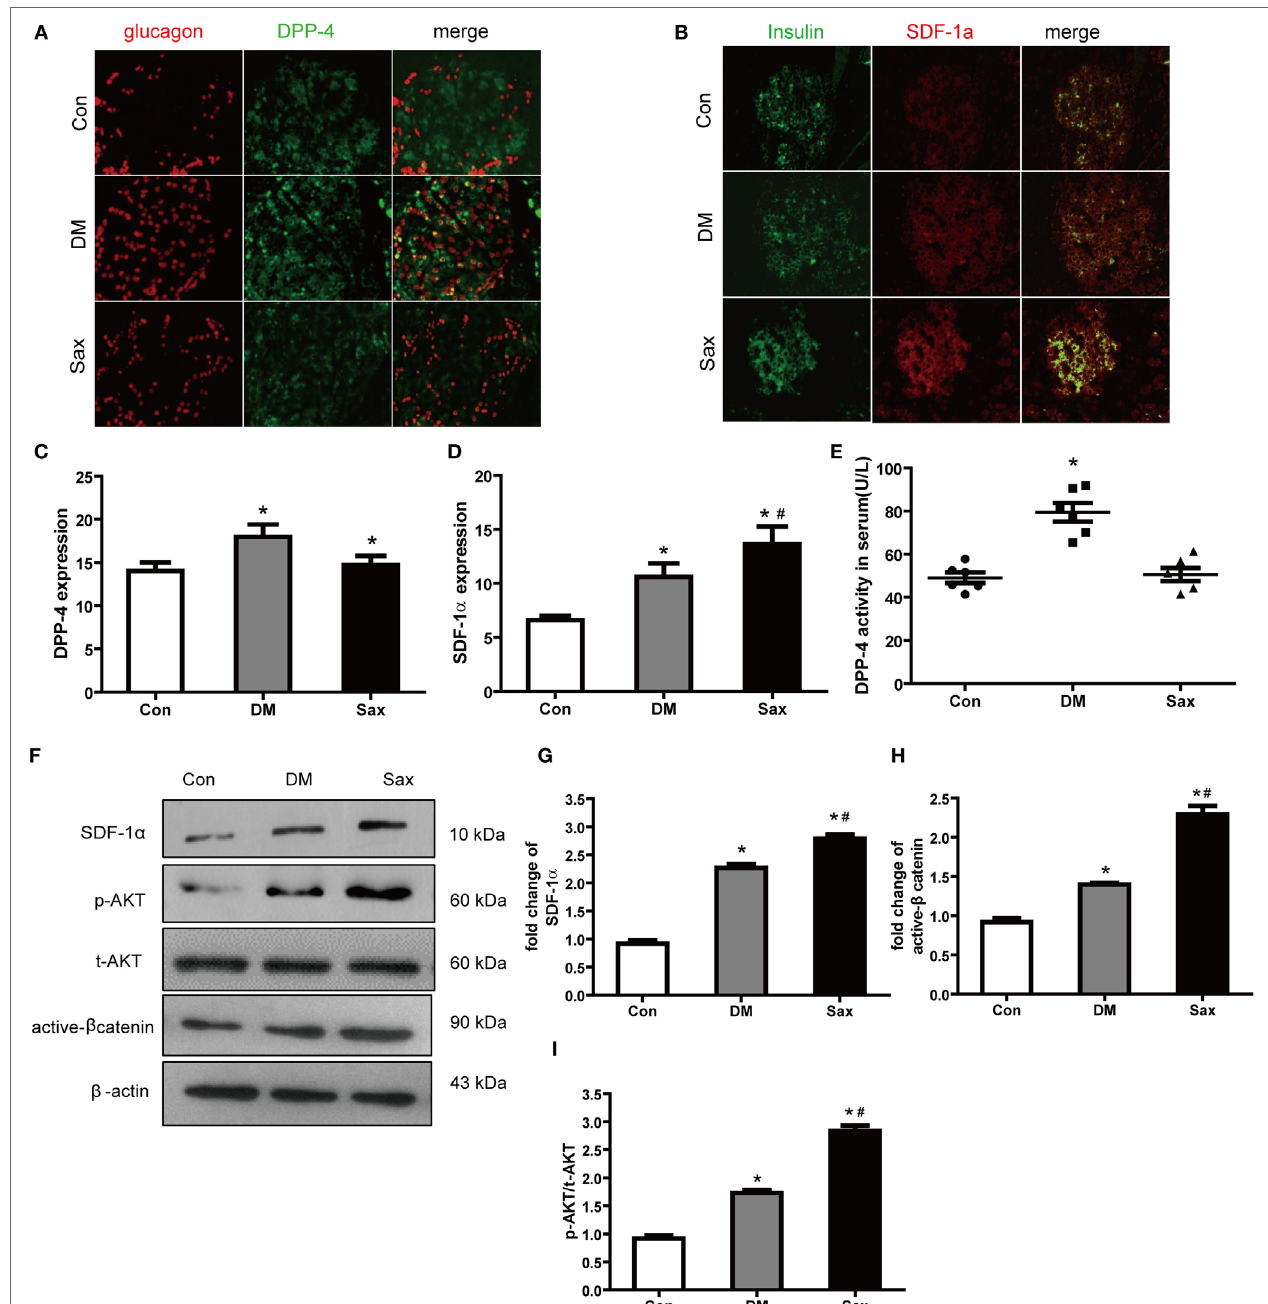
FigUre 4 | Saxagliptin strengthened the stromal cell-derived factor-1 α (SDF-1 α )/Akt/ β -catenin pathway in high-fat diet/STZ-induced diabetic rats. Double immunofluorescence images of pancreatic islets stained with antibodies to glucagon (red) and DPP-4 (green) (a) . Double immunofluorescence images of pancreatic islets stained with antibodies to insulin (green) and SDF-1 α (red) (b) , × 400. The graphs on the right represent the average of DPP-4 expression (c) and SDF-1 α expression (D) in rat islets. DPP-4 enzyme activity in serum from each group (e) . Western blot analysis for active β -catenin, SDF-1 α , and phosphorylation of Akt (p-AKT) in isolated islets of different groups (F) . Densitometric analysis of indicated protein expression (g–i) . n = 4 for each group. Data were reported as mean ± SEM. * p < 0.05 compared with the control group, # p < 0.05 compared with DM group. Con, control; DM, diabetes; Sax,